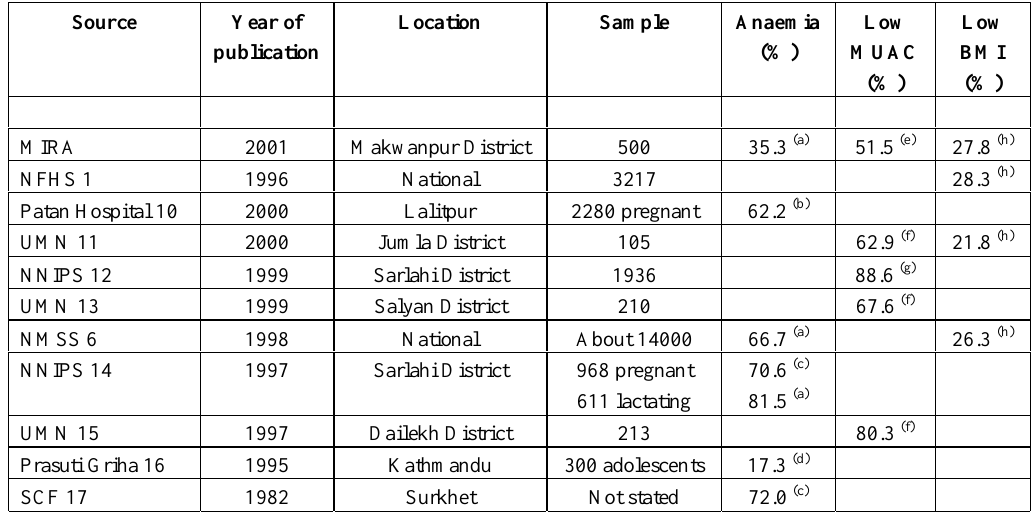
Table 3: Other studies of nutritional status and anaemia in